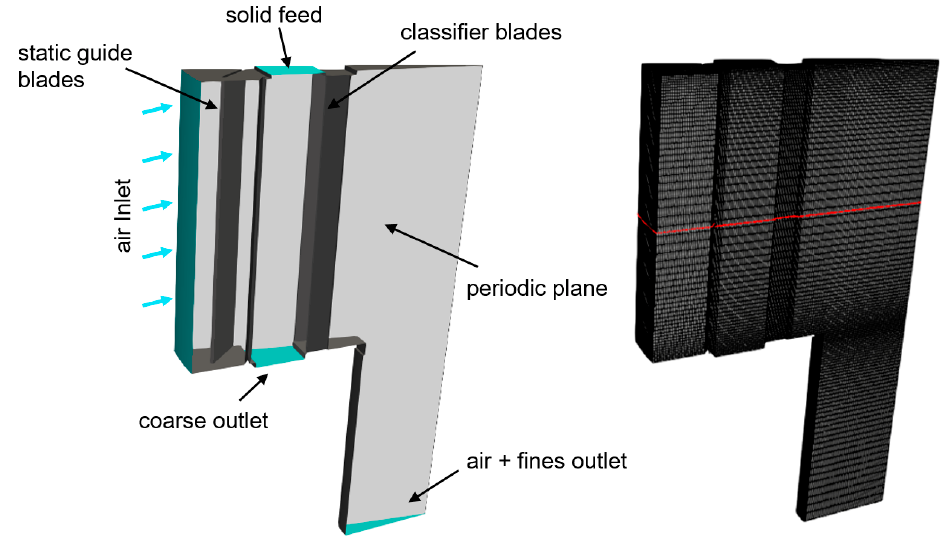
Figure 3. 3D domain, boundary types, and CFD grid.